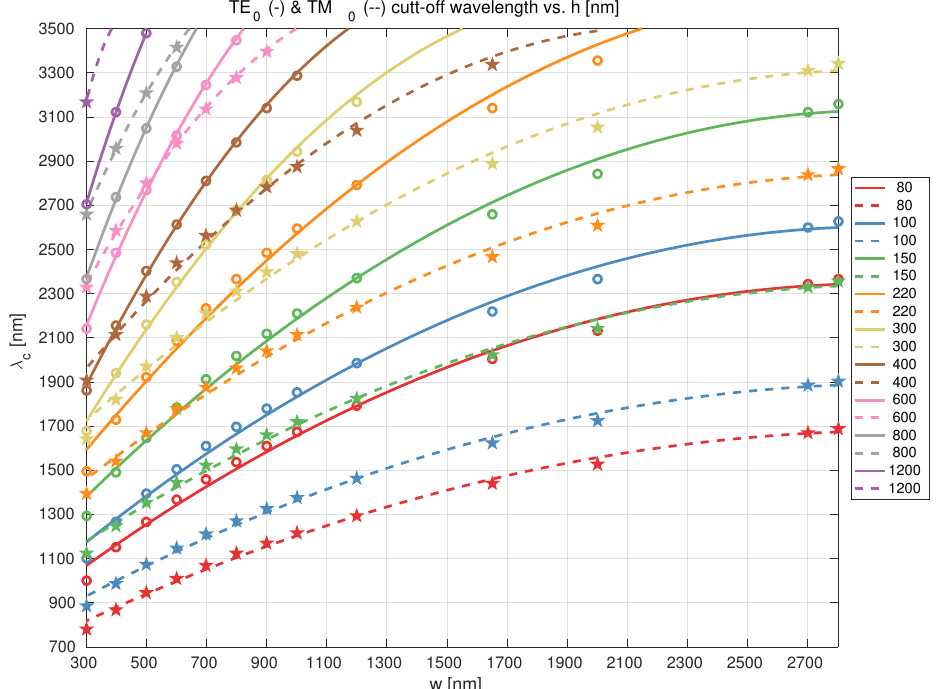
Figure 3. Strip silicon nitride waveguide cut-off wavelength for TE 0 and TM 0 modes vs. waveguide width, and for different Si 3 N 4 film heights (80–1200 nm) (symbols: simulation points; lines: fit, continuous TE 0 , dashed TM 0